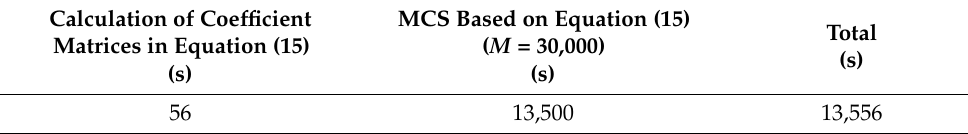
Table 2. Computation time of the ETDM-based Monte-Carlo simulation